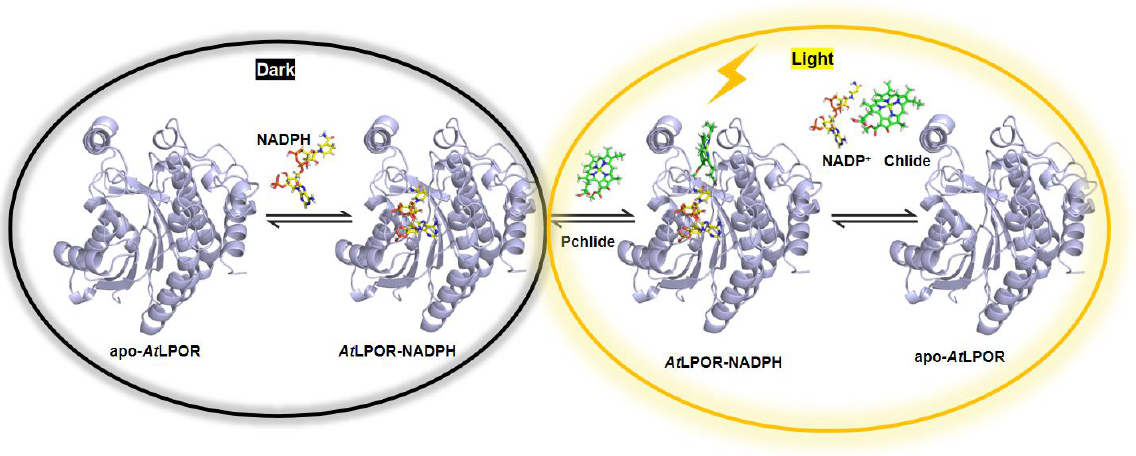
Figure 1. Kinetic mechanism of At LPOR. Note ordered binding of Pchlide substrate and NADPH cofactor.